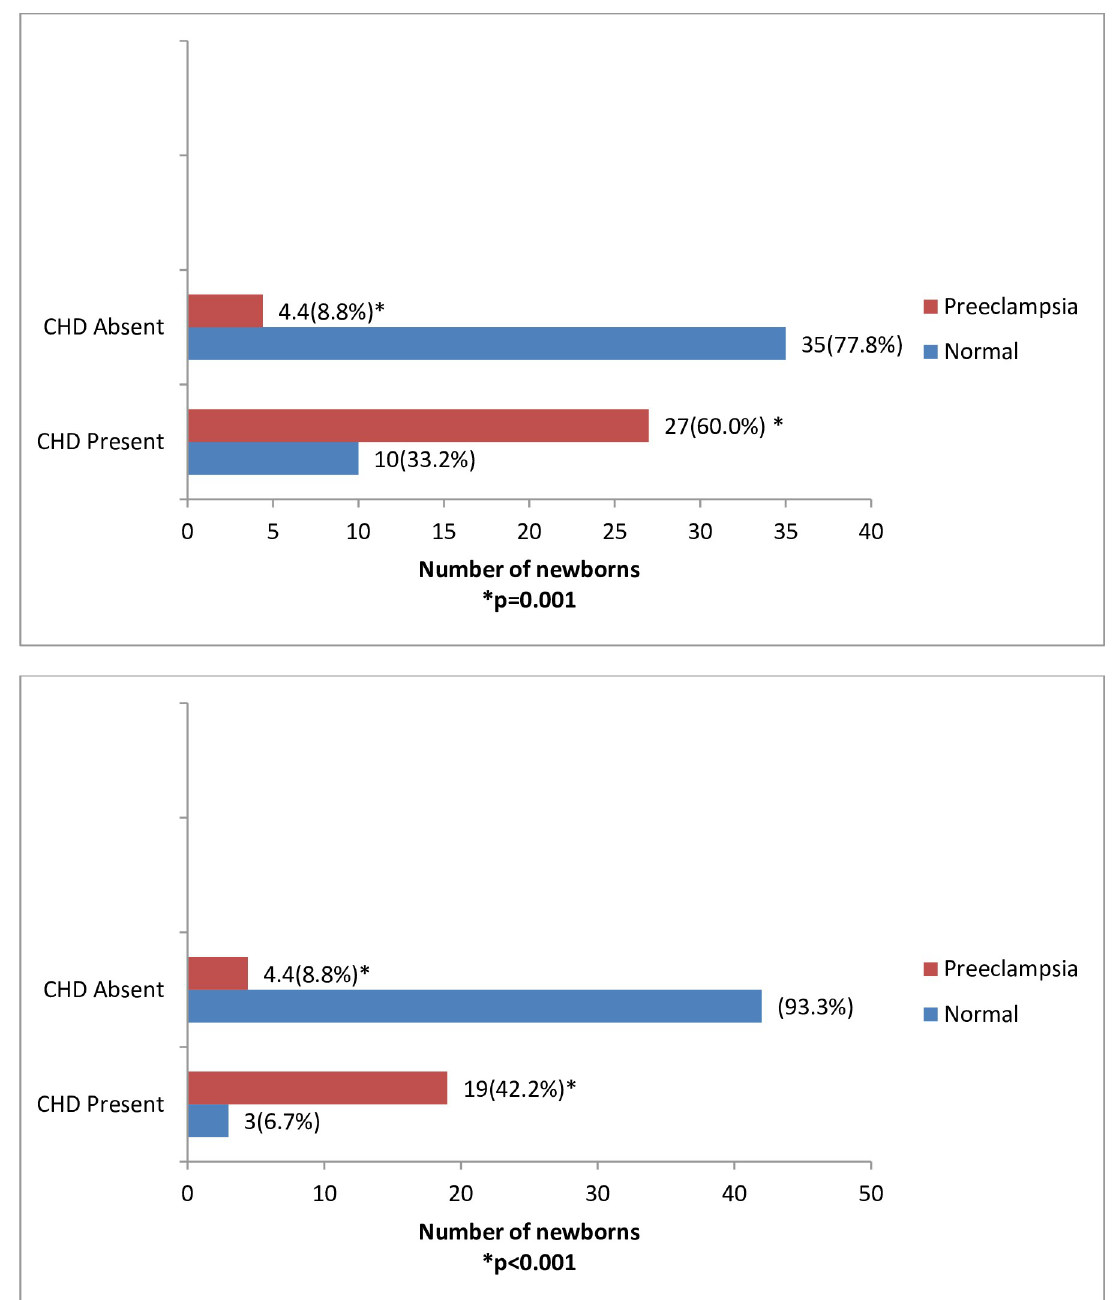
Fig 1. (A) Distribution of Congenital Heart Disease (CHD) in newborns by preeclampsia exposure status at the end of day 7. (B) Distribution of Congenital Heart Disease (CHD) in newborns by preeclampsia exposure status at the end of day 28. Atrial septal defect (ASD), patent ductus arteriosus (PDA), patent foramen ovale (PFO) and ventricular septal defects (VSD) were the prevalent CHD types observed which persisted beyond the first week of life. Isolated ASD and VSD were observed only in newborns born to women with preeclampsia (Table 2). The PDA in newborn of normal pregnancy and 8 (8.9%) of those newborns of preeclamptic women had closed by the 28 th day of life (Table 2).